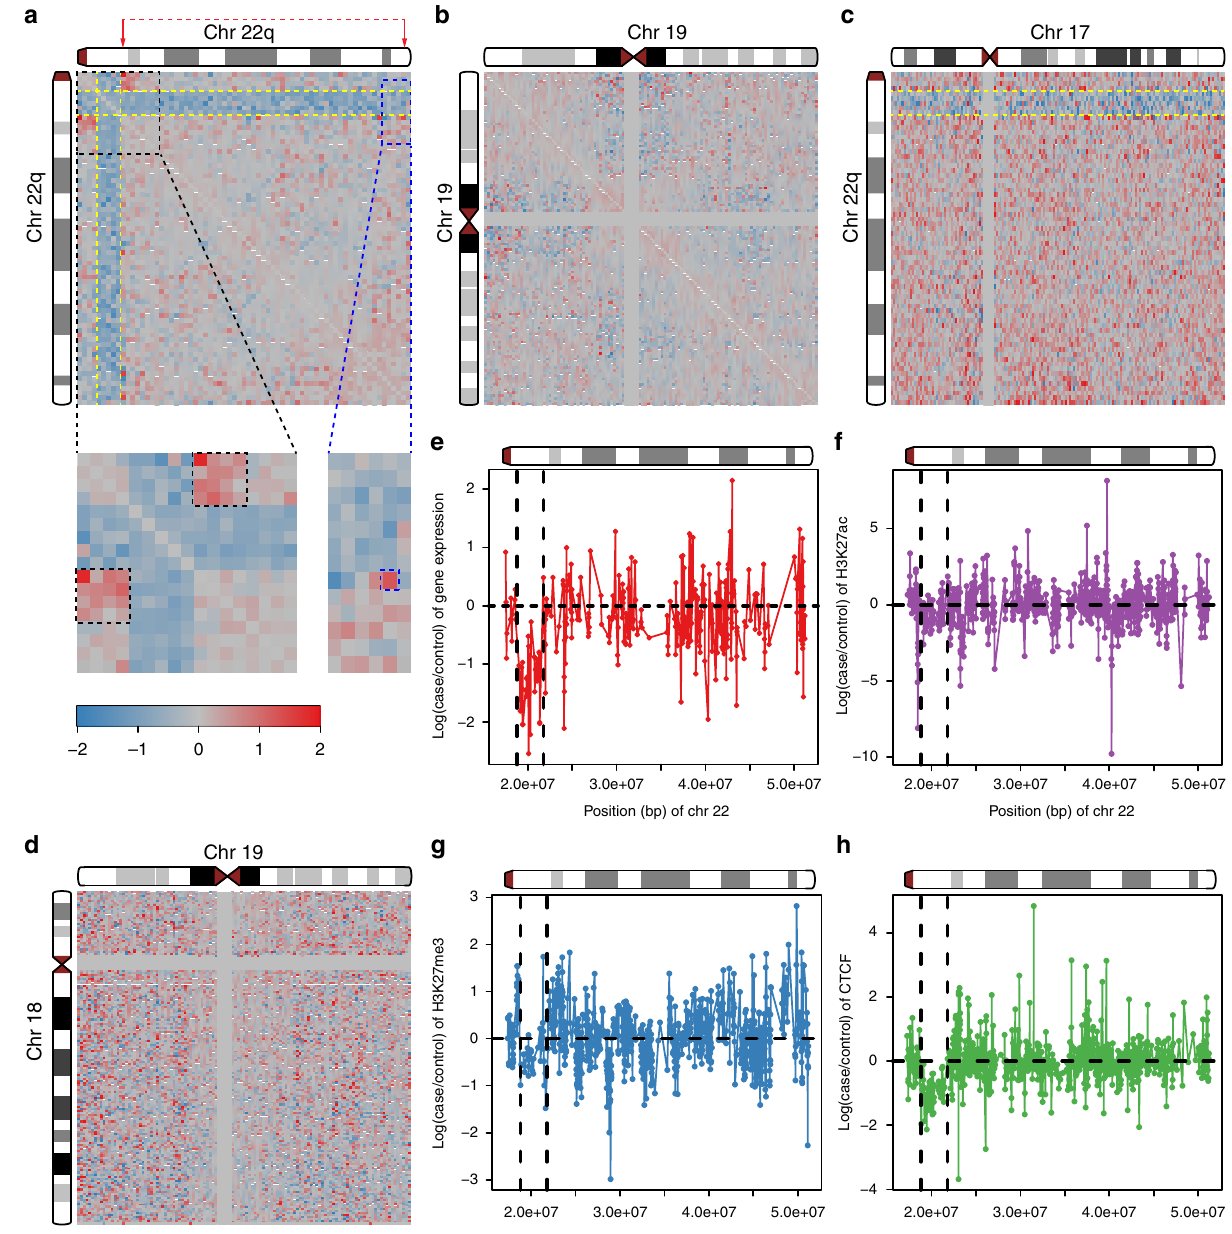
Fig. 1 Effects of the 22q11.2 deletion on chromosome interactions, gene expression and chromatin marks. a – d Each pixel in the heatmaps represents the intra- or inter-chromosomal contact frequency in Hi-C data from 22q11.2del cell lines ( n = 5) versus control cell lines ( n = 6) for a 500-kbp region. Yellow dashed lines indicate the 3-Mbp deletion on chromosome 22q. The color scale goes from − 2 (blue) to 0 (gray) to 2 (red). a Fold change of cis-contacts along chromosome 22 in 22q11.2del versus control cell lines. Black boxes indicate increased contacts between the deletion- fl anking regions in 22q11.2del cell lines. Blue box: the signal for increased contacts between the centromere – distal deletion- fl anking region and the telomeric end of chromosome 22q (red arrows and dashed red line indicate the corresponding chromosome folding event). b Lack of intra-chromosomal fold change of contacts for chromosome 19. c Fold change of inter-chromosomal contacts between chromosome 22 and chromosome 17. d Lack of inter-chromosomal fold change of contacts between chromosome 18 and chromosome 19. e Log2-transformed fold change of gene expression for genes on chromosome 22q in RNA-Seq data from 22q11.2del ( n = 5) versus control ( n = 9) cell lines. Each point represents a gene. f – h Log2-transformed fold change in ChIP-Seq signals in 22q11.2del versus control cell lines. f H3K27ac histone modi fi cations ( n = 5 for 22a11.2del and n = 4 for control cell lines). g H3K27me3 histone modi fi cations ( n = 5 for 22a11.2del and n = 4 for control cell lines). h CTCF-binding sites ( n = 4 for 22a11.2del and n = 3 for control cell lines). Black vertical dashed lines indicate the 3-Mbp deletion on chromosome 22q in e –